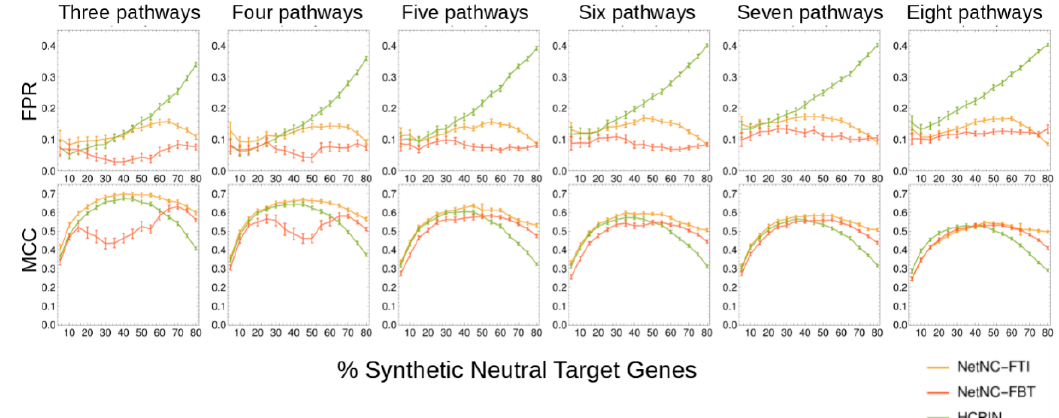
Figure 2. Evaluation of NetNC and HC-PIN on blind test data . Performance values reflect discrimination of KEGG pathway nodes from Synthetic Neutral Target Genes (STNGs), shown for NetNC-FTI (orange), NetNC-FBT (red) and HC-PIN (green). False positive rate (FPR, top row) and Matthews Correlation Coefficient (MCC, bottom row) values are given. Data shown represents analysis of TEST-CL_ALL, which included subsets of three to eight pathways, shown in columns, and sixteen %STNG values were analysed (5% to 80%, x -axis). NetNC performed best on the data examined with typically lower false positive rate and higher MCC values. Error bars reflect 95% confidence intervals calculated from quantiles of SNTG resamples. Also see Table S2.